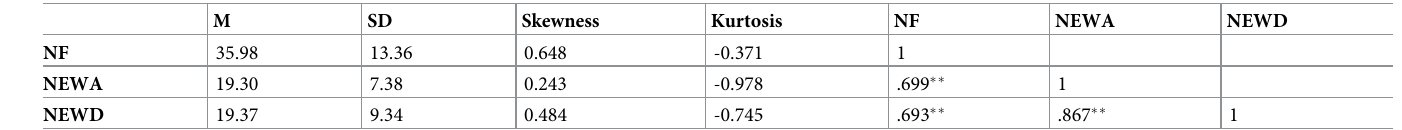
Table 1. Descriptive statistics for NF, NEWA and NEWD (N =